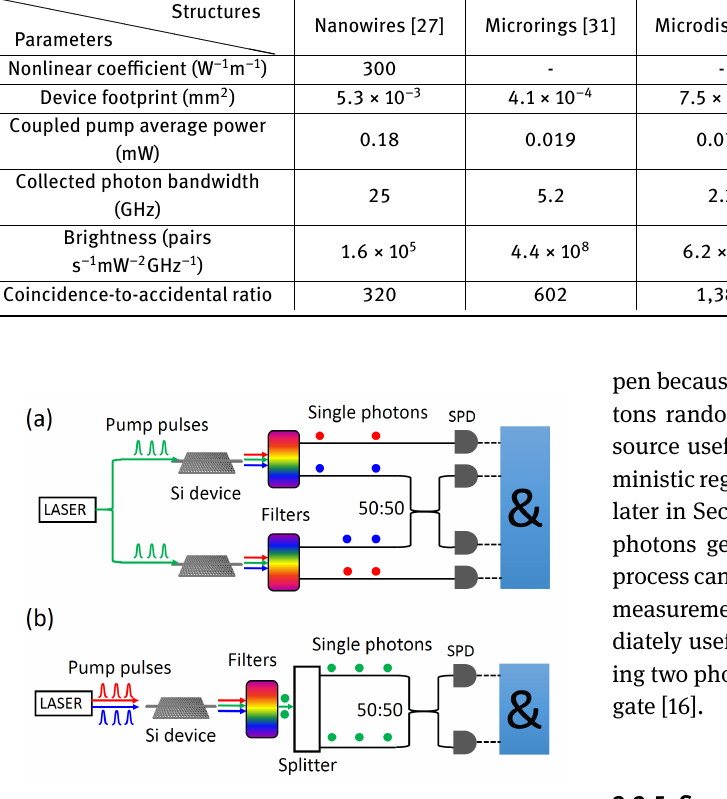
Fig. 7. In the time-reversed HOM interference